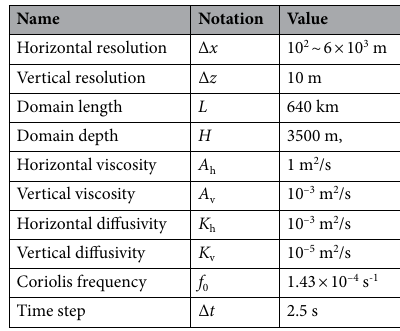
Table 1. Parameters in the